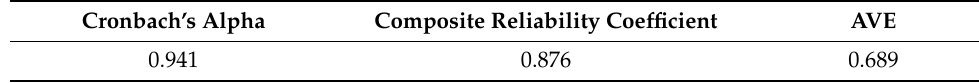
Table 4. Results of reliability and convergent validity.